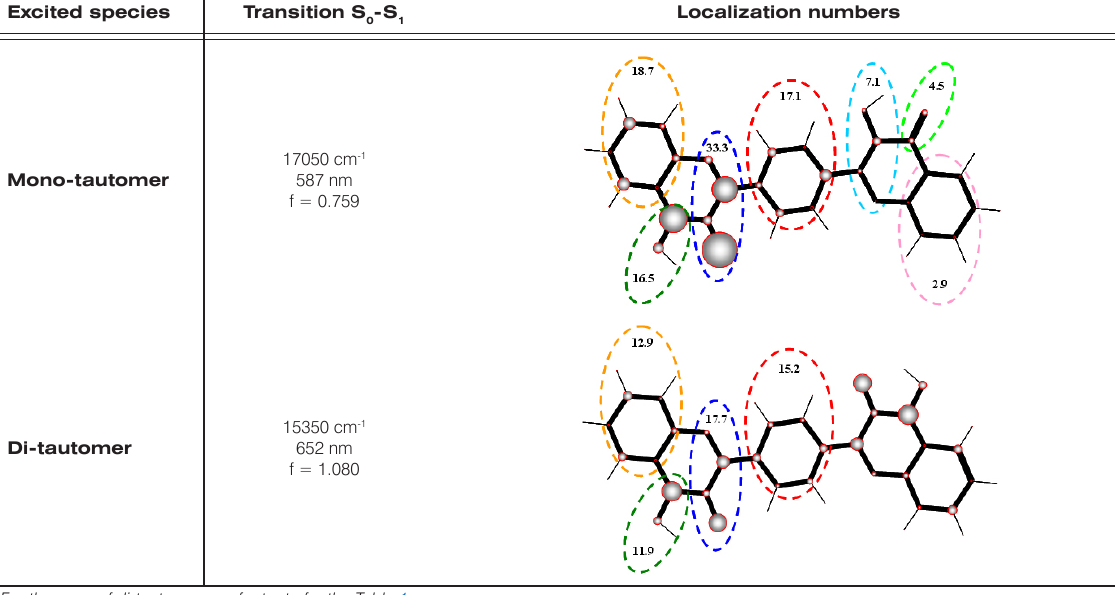
Table 3. Calculated spectral characteristics of the excited mono- and ditautomeric forms of bis -flavonol. Excited species